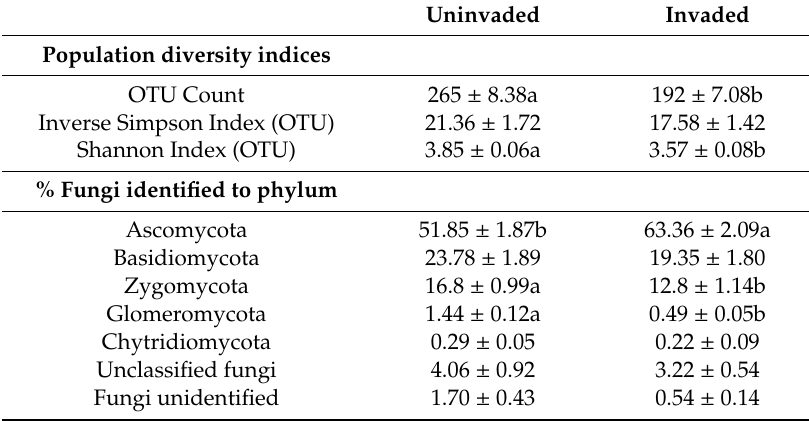
Table 2. Population diversity indices and percentage of fungi operational taxonomic units (OTUs) identified to phylum level (mean ± standard error). Significant di ff erences ( p < 0.05 on the basis of ANOVAs) between the uninvaded and the invaded site were indicated by di ff erent letters ( n = 25 per